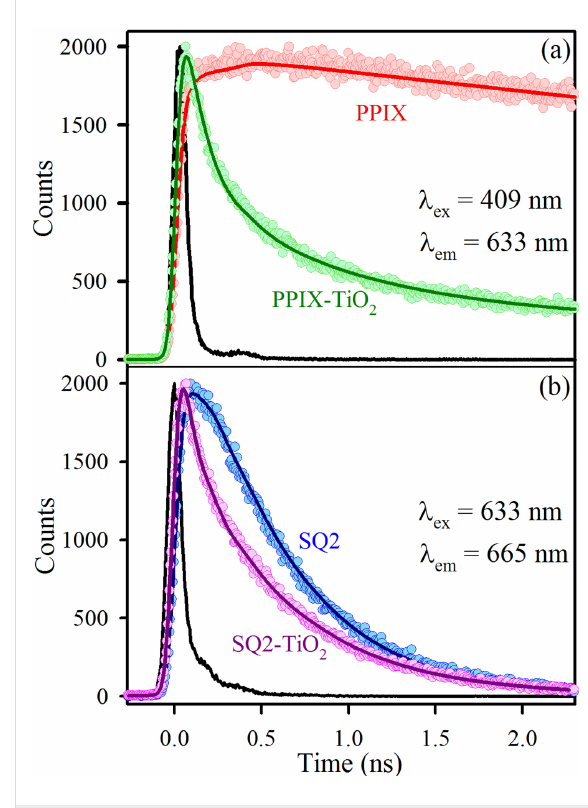
Figure 4: (a) Fluorescence decay profiles of PPIX (red) and PPIX at- tached to TiO 2 (green), (b) fluorescence decay patterns of SQ2 (blue) and SQ2 attached to TiO 2